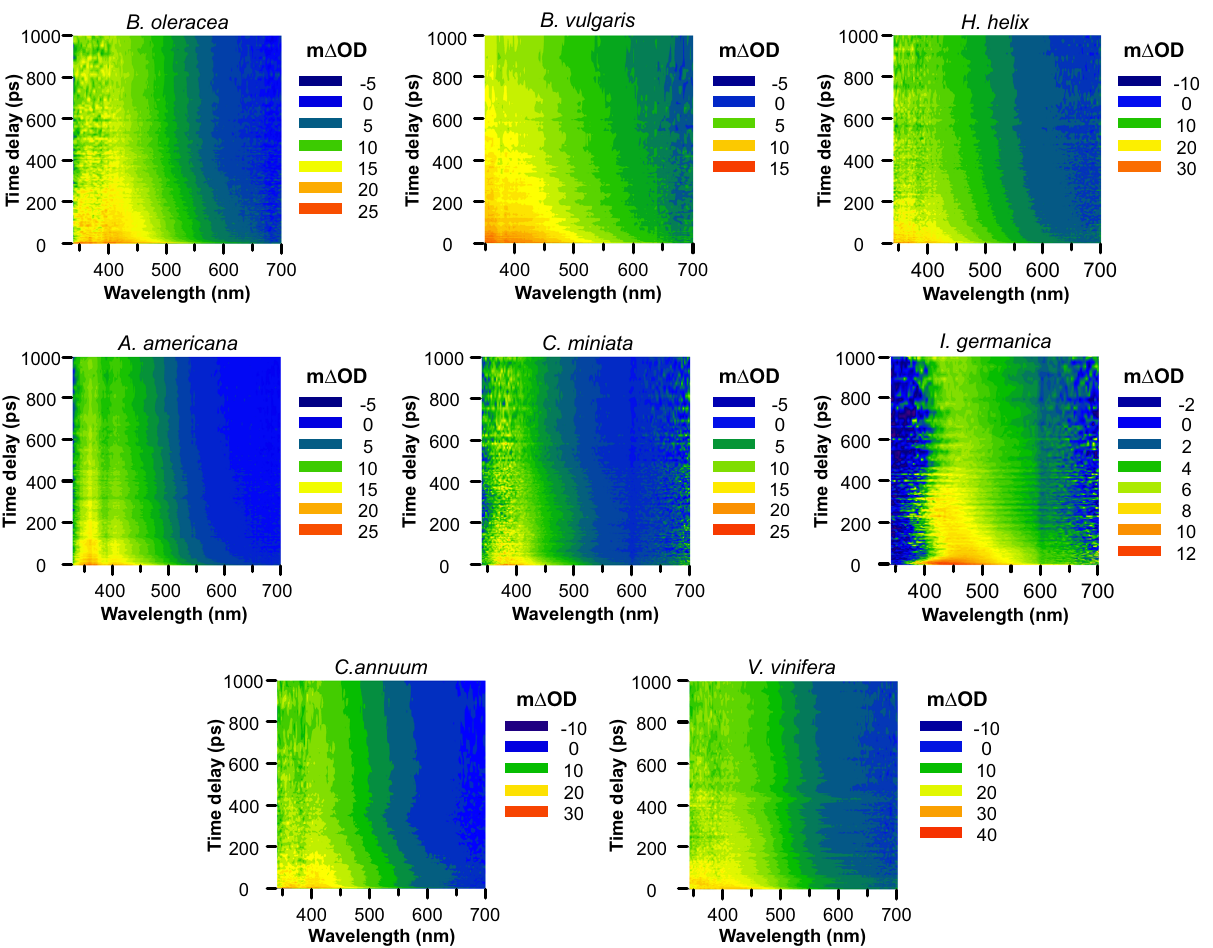
Fig. 3 Transient absorption spectra (TAS) of isolated plant cuticles. Heat maps of cuticles from different species displaying differences in optical density (m Δ OD) with time and wavelength after a pump pulse photoexcitation of 300 nm. Brassica oleracea , Beta vulgaris , Hedera helix , Agave americana ,